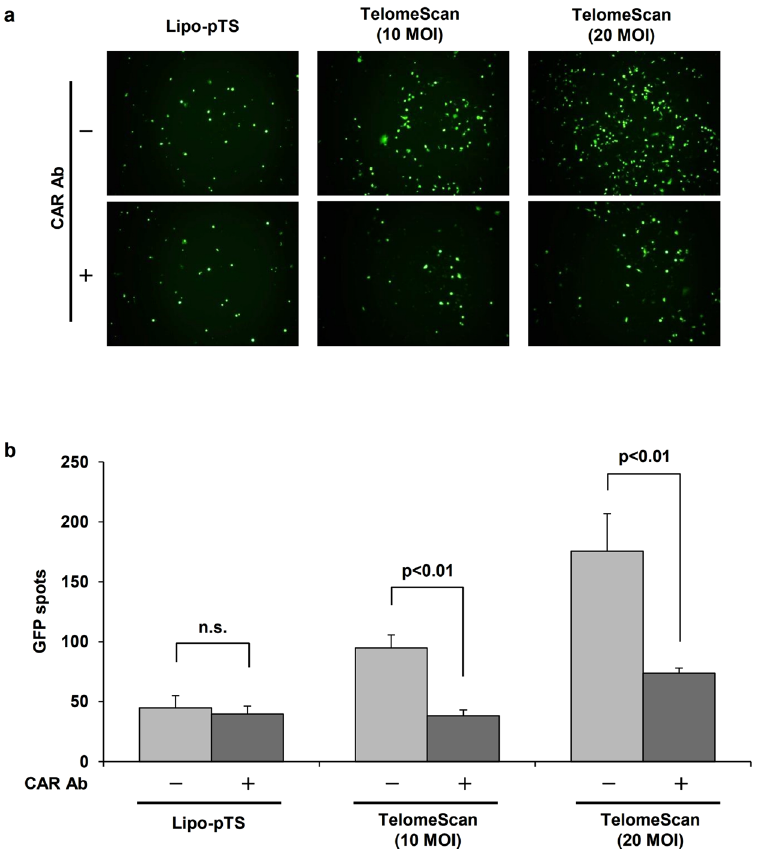
Figure 4. CAR-independency of Lipo-pTS. ( a ) HCT116 cells are treated with Lipo-pTS or TelomeScan with or without anti-CAR antibody pretreatment for 3 days, and GFP spots are observed on fluorescence microscopy. ( b ) The number of GFP spots is counted.